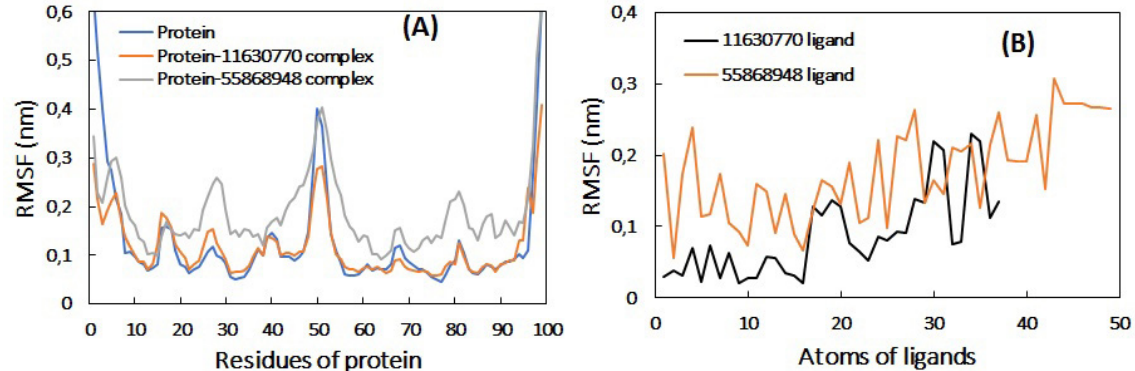
Fig. 8. Root mean square fluctuation (RMSF) of HIV-1 protease in the absence and presence of 11630770 and 55868948. (B) The average RMSF value of each atom of ligands during the MD simulation.